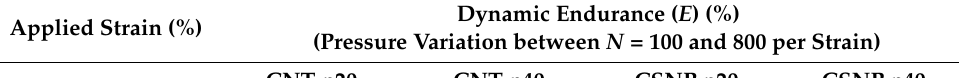
Table 1. Dynamic E summary for the free-standing nanocomposite transmitters under applications of various strain value.